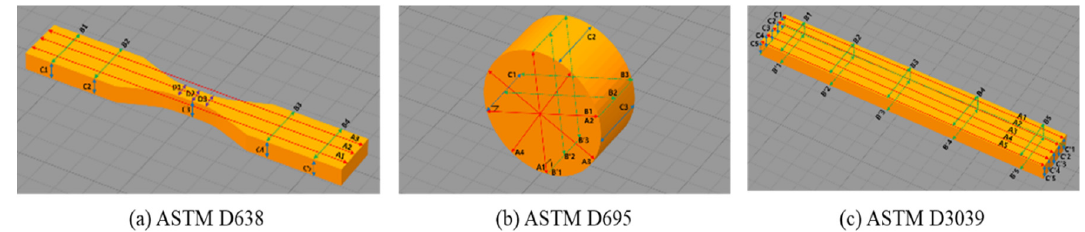
Figure 4. Measured dimensional specifications of each design type. ( a ) ASTM D638; ( b ) ASTM D695; ( c ) ASTM D3039.